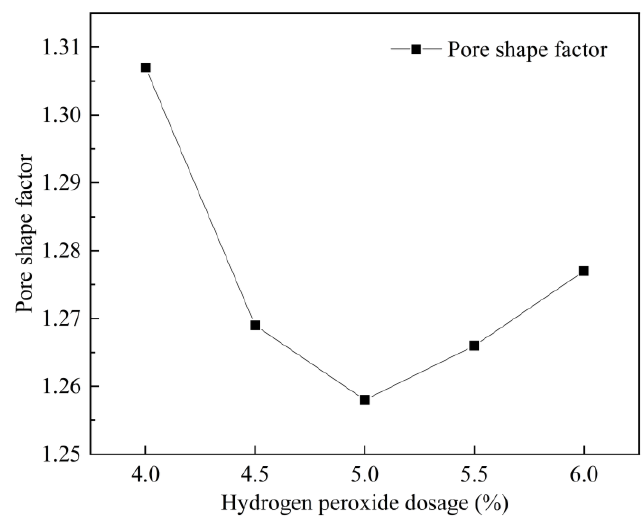
Figure 14. Effect of hydrogen peroxide on pore shape factor.